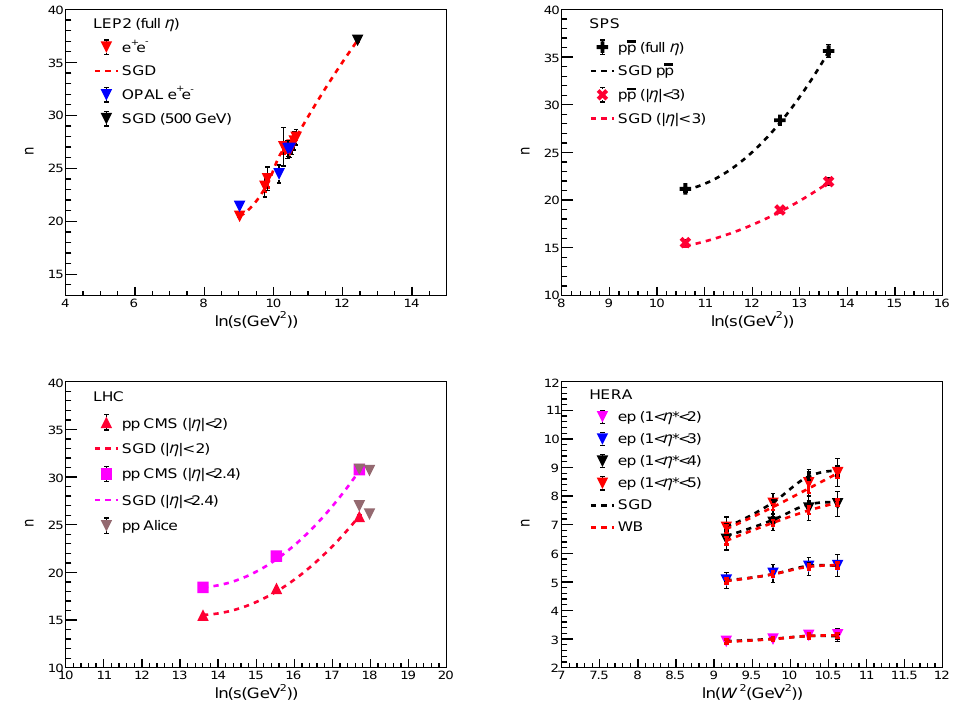
Figure 16. (cid:104) n (cid:105) for e + e − at LEP [53–57], pp at SPS [41,58], pp at LHC [59,60] and ep at HERA [33] collisions versus ln ( s ) /ln ( W 2 ) , compared with the predictions from SGD (dotted